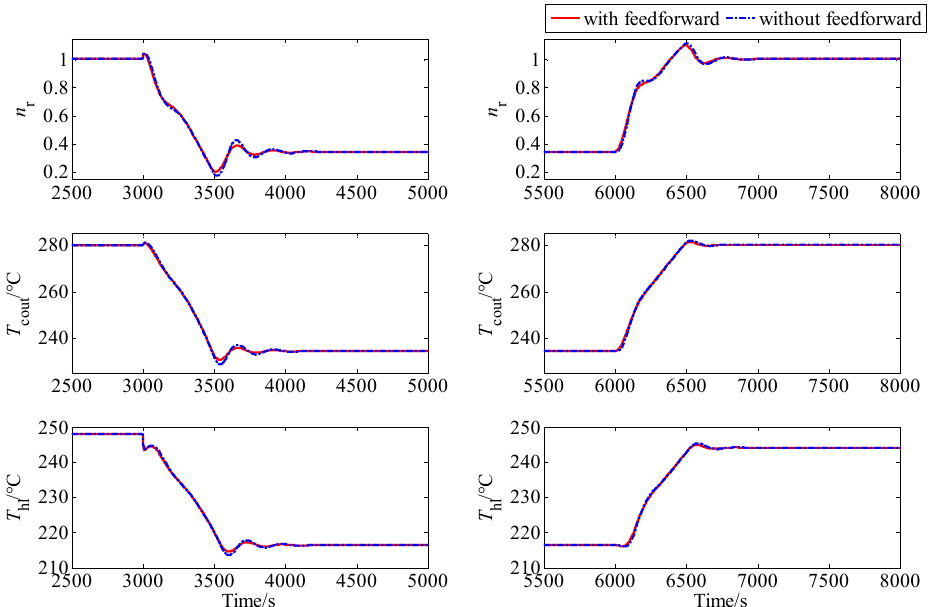
Figure 7. Responses of PC and IC process variables in the case of load maneuvering, n r : neutron flux, T cout : core outlet temperature, T hl : IC hot leg temperature.